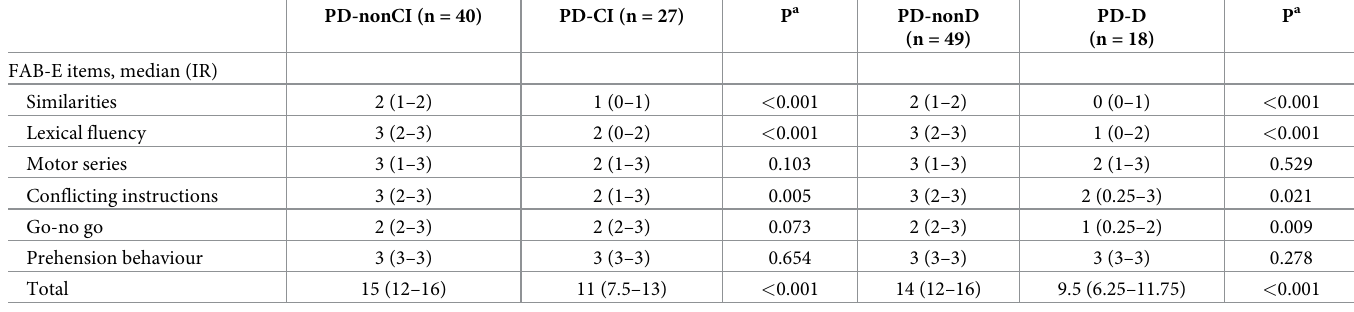
Table 5. Comparison of the performance of the FAB-E scores between Parkinson’s disease patients with and without cognitive impairment, and with and without dementia (n = 67).